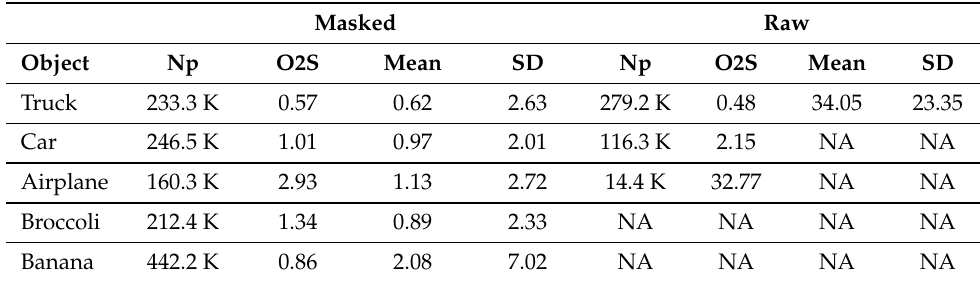
Table 6. Pix4d masked and raw Point clouds mean and standard deviation distances relative to reference point cloud in